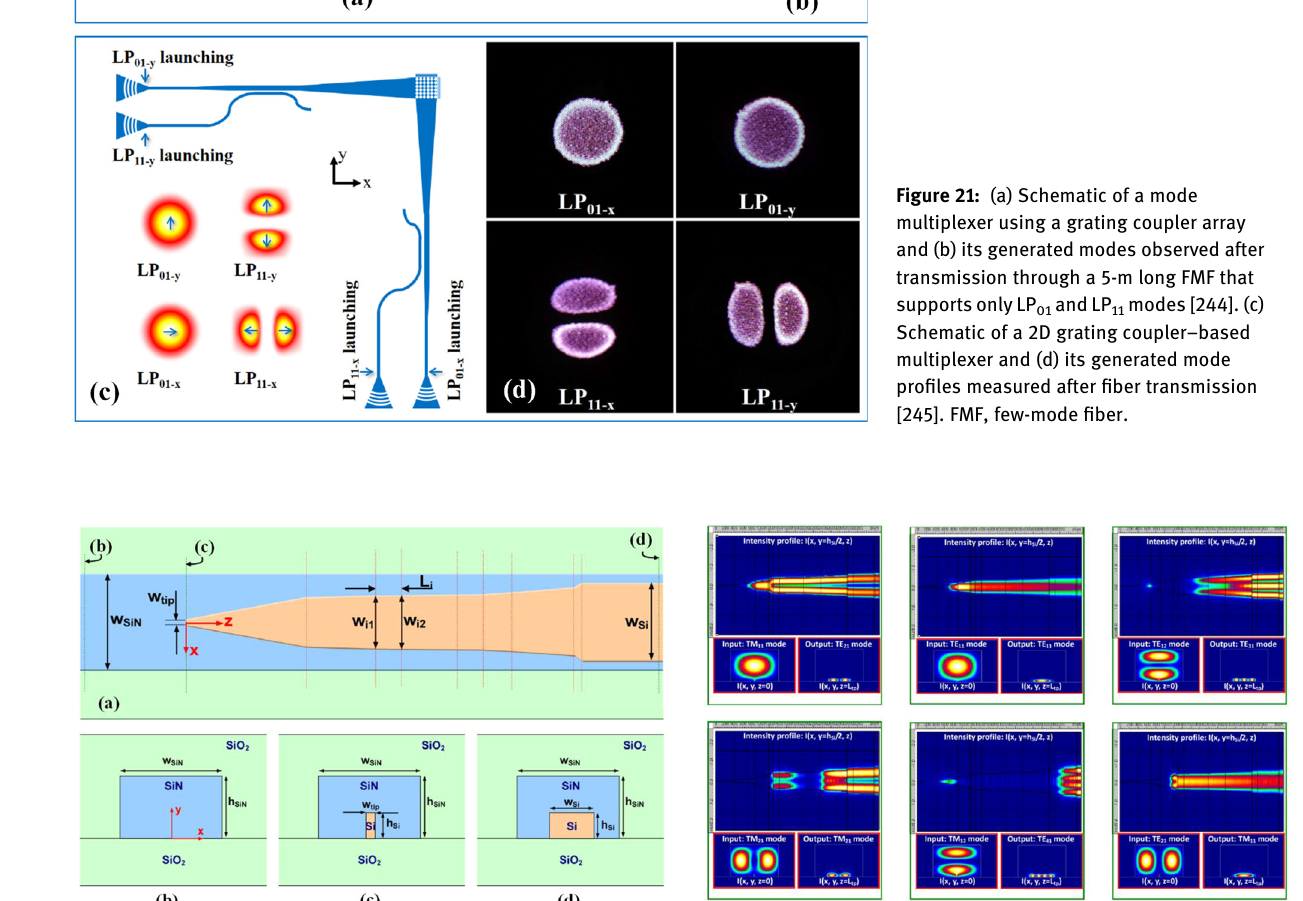
Figure22: (a)Schematicofmodeconvertor;(b) – (d)crosssectionofaconvertoratdifferentlocations;(e)simulatedlightpropagationshowing the mode conversion